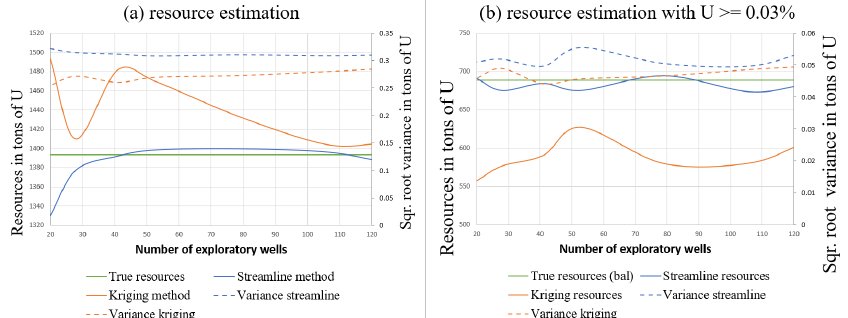
Figure 15. Comparison in resource estimation (left vertical axis) and square root of dispersion variance (right vertical axis) between streamline-based stochastic method and ordinary kriging where ( a) total in-situ resources in tons from all nodes; ( b ) recoverable resources in tons with concentration higher than 0.03%.